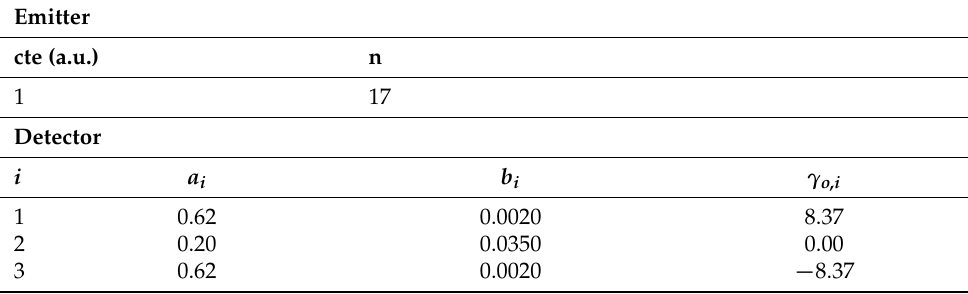
Table A2. Emitter and detector